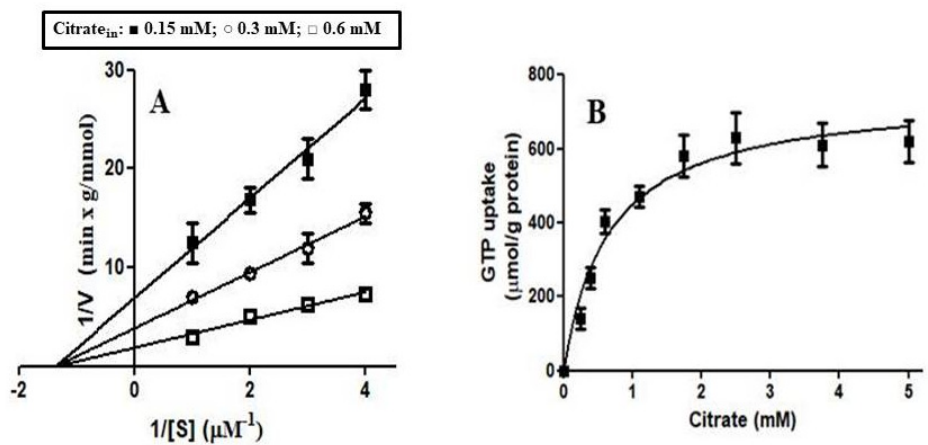
Figure 7. Dependence of the rate of CIGU in proteoliposomes reconstituted Ggc1p on the external GTP concentration and intraliposomal citrate concentration. ( A ) [8- 3 H] GTP was added at the concentrations indicated to proteoliposomes containing 0.15 ( ■ ), 0.3 ( ○ ) and 0.6 mM ( □ ) citrate. ( B ) An amount of 10 μ M [8- 3 H] GTP was added to proteoliposomes containing citrate at the concentrations indicated.